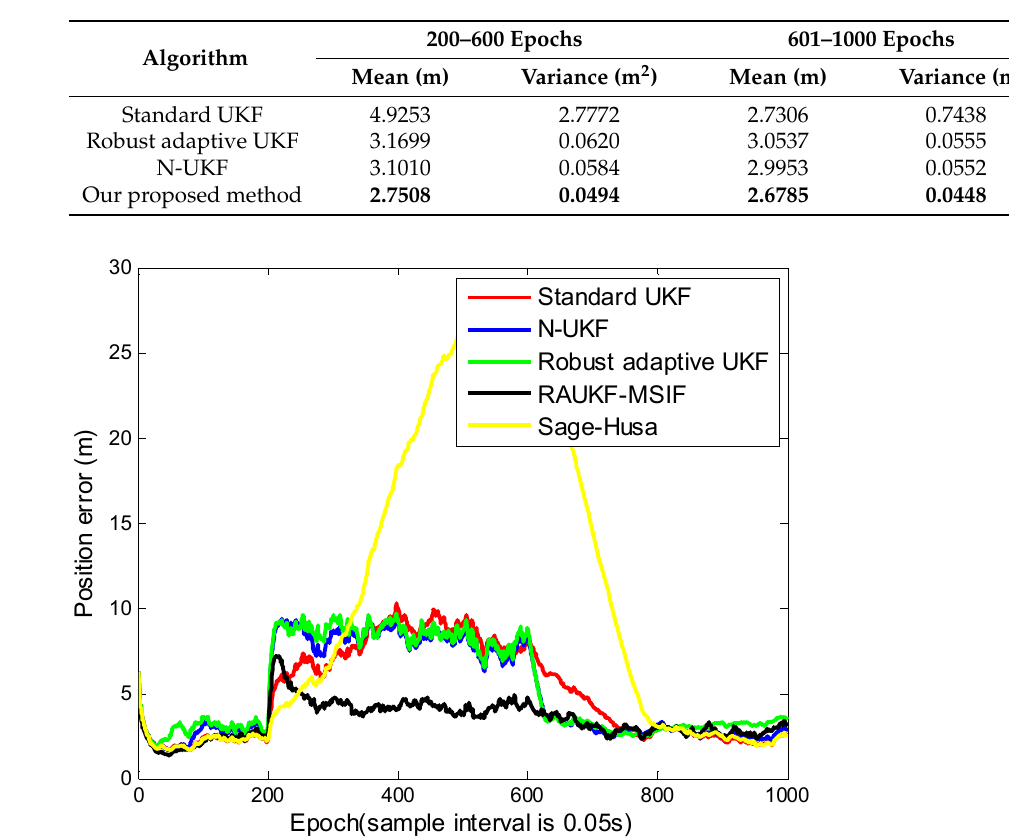
Figure 4. Position tracking errors for Case 1. Table 1. Mean RMSEs of the overall estimation errors for the simulation Case 1. The bold numbers stand for the minimum.